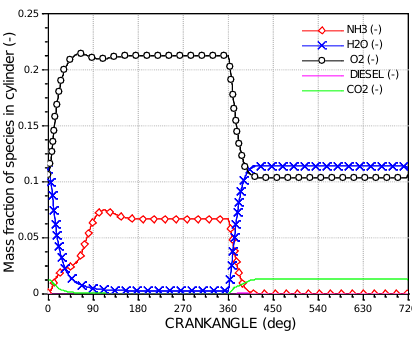
Fig. 8. Mass fraction of in-cylinder species